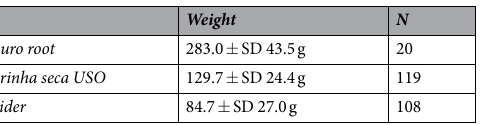
Table 4. Stone tool weight mean for each resource explored. N =